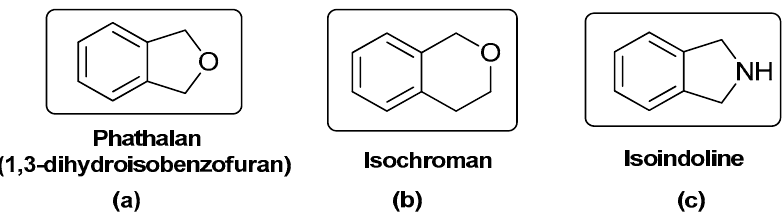
Figure 1. Chemical structure of: ( a ) phthalan; ( b ) isochroman; ( c ) isoindoline. Nitrogen-containing heterocycles are important substructures that are found in natural and synthetic alkaloids [45,46]. They also serve as an important source of pharmaceuticals and have inspired synthetic chemists to develop novel chemical transformations. For instance, indole [47–49] and its derivatives, such as isoindole [50,51] and isoindoline [52] (Figure 1c), are the basis for compounds possessing relevant biological activities. In par- ticular, isoindoline derivatives are inhibitors of several enzymes involved in numerous diseases, including diabetes, obesity, heart failure, cancer, and mood disorders [53]. More- over, isoindoline-based ligands are very interesting due to their modular set-up [54]. Finally, isoindoline pigments are particularly relevant, since they cover a wide range of colors from greenish-yellow to red and brown [55].